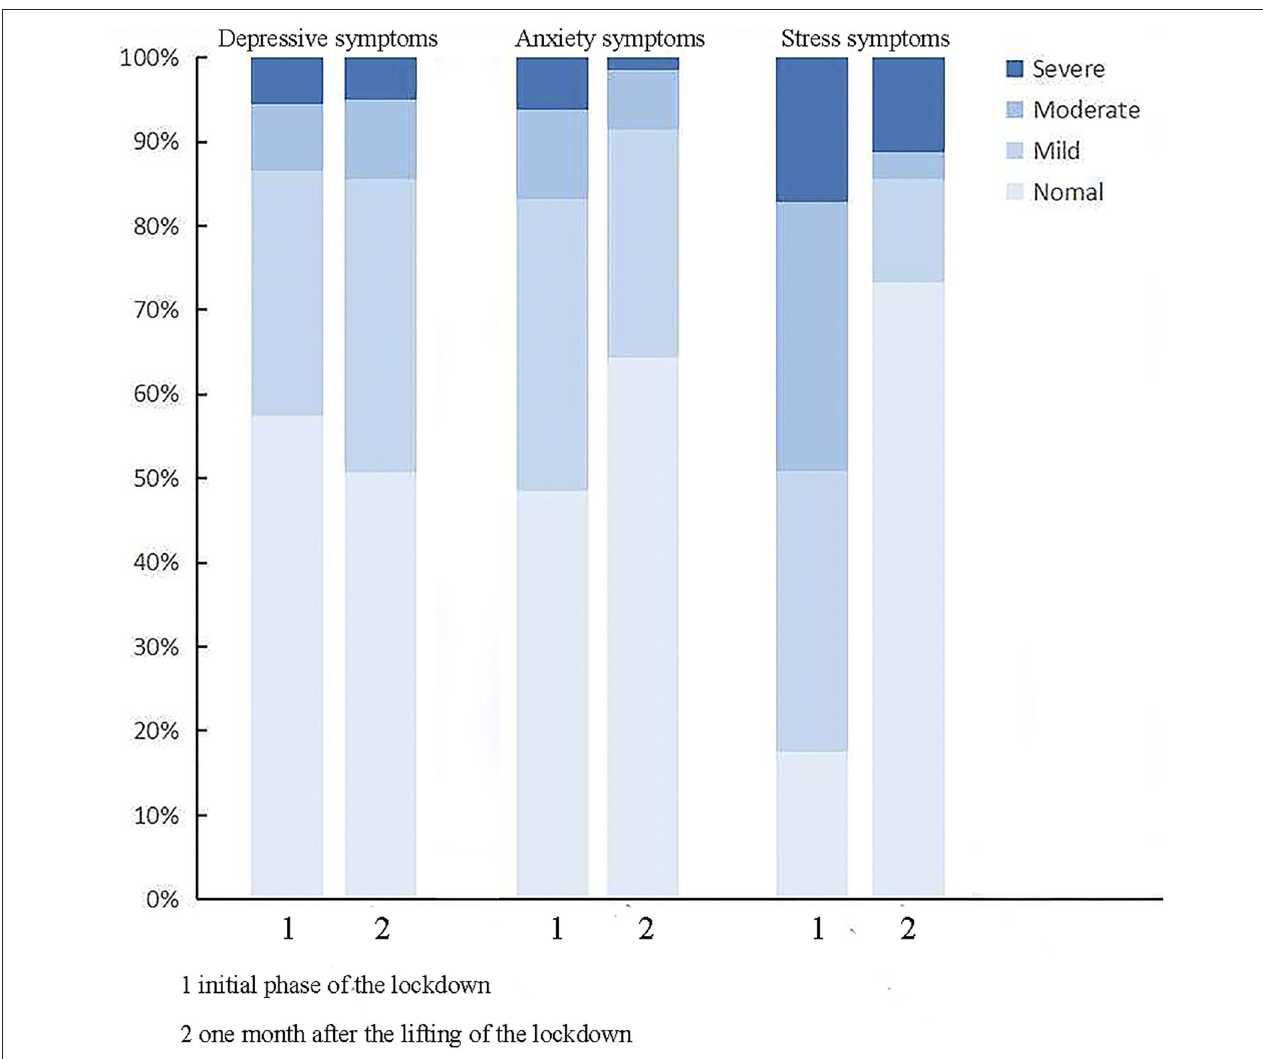
FIGURE 1 | Distribution of severity categories of depressive symptoms, anxiety symptoms, and stress in the initial phase of the lockdown and 1 month after the lifting of the lockdown of COVID-19.